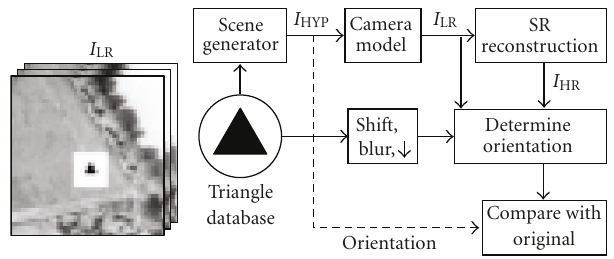
Figure 6: Left: example of simulated data I LR . Right: flow diagram of the simulated data